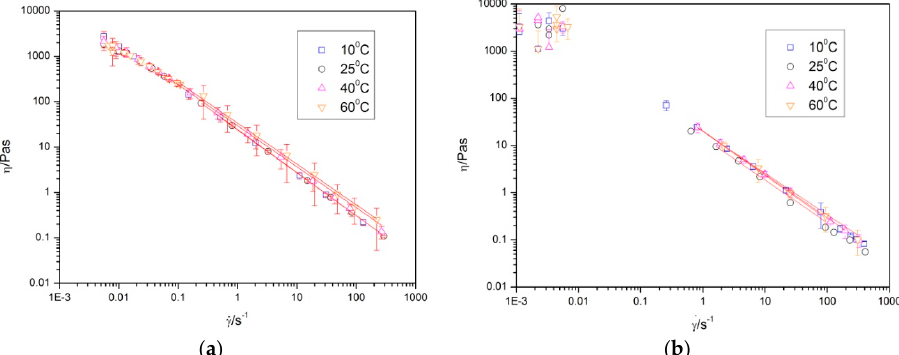
Figure 5. Influence of the temperature on the flow curves of aqueous solutions containing ( a ) 1 wt % diutan gum and ( b ) 1 wt % rhamsan gum. diutan gum and ( b ) 1 wt % rhamsan